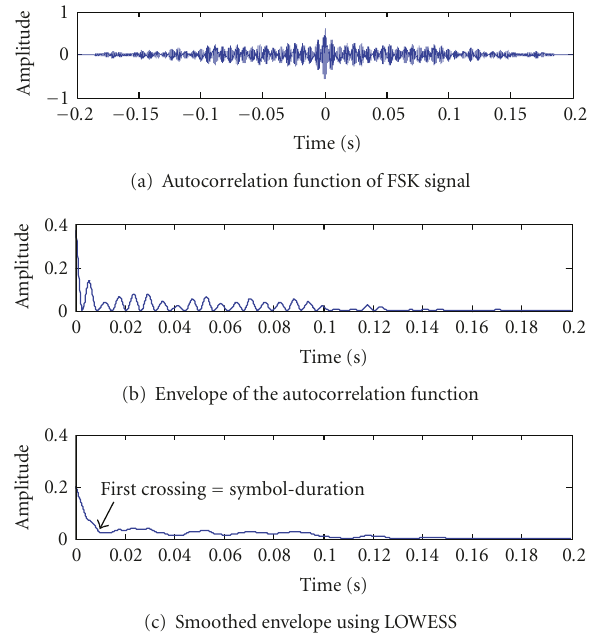
Figure 8: The autocorrelation function of FSK signal and the smoothed curve for symbol-duration estimate.